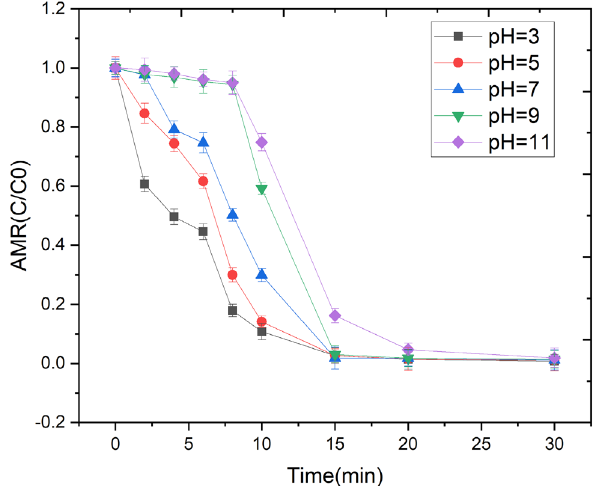
Fig. 2 Effect of ZVI concentration on AMR degradation in persulfate–ZVI system. [AMR] [ZVI] = 1–30 mM, Temp. = 25 °C, pH 7.0 0